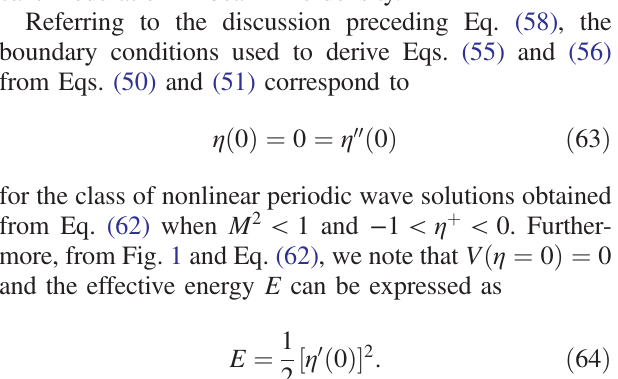
0 and E ¼ 0 , T ¼